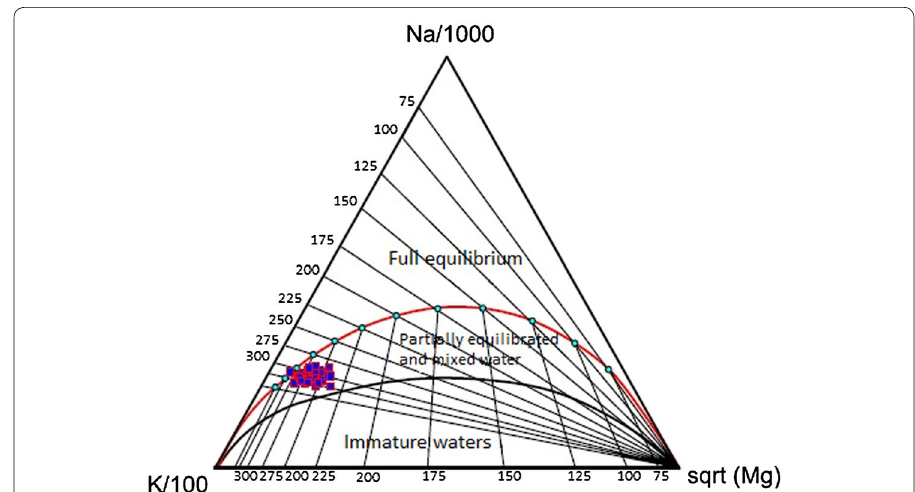
Fig. 7 Na–K–Mg ternary diagram and geo‑indicator representing equilibrium state of discharging waters from NW Sabalan wells (Kosari and Sattari